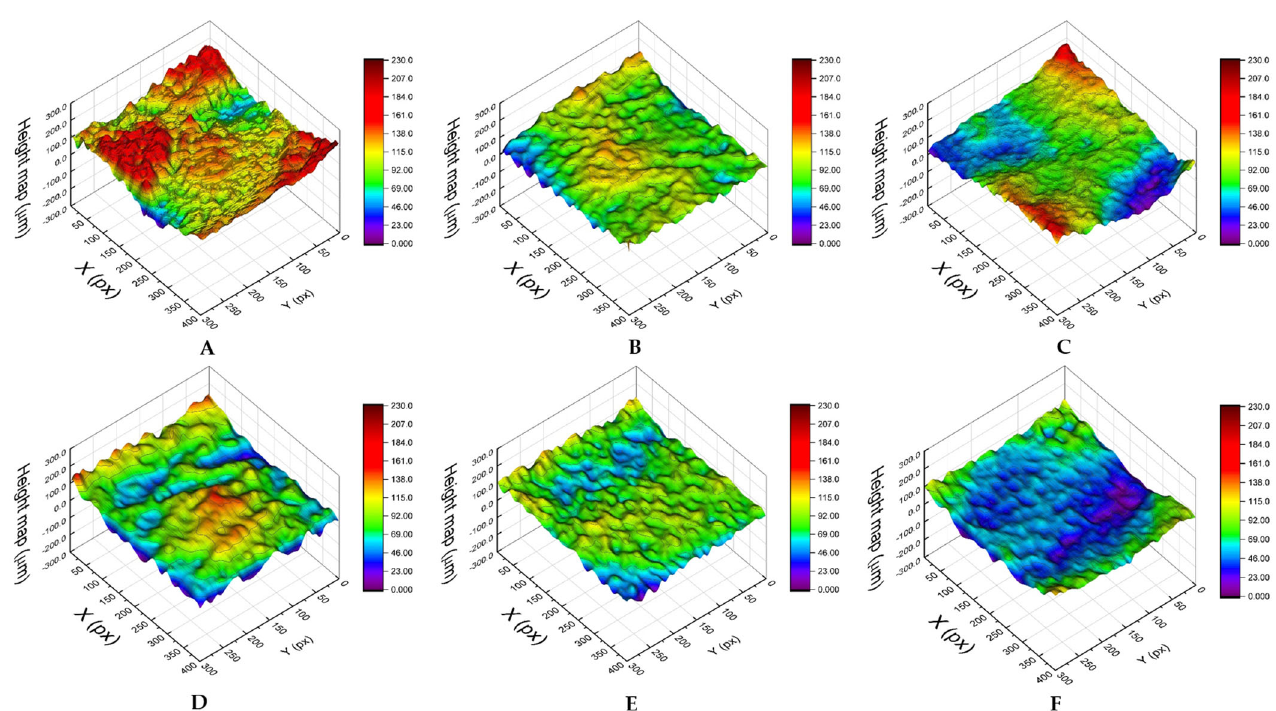
Different letters show significant differences for p ≤ 0.05, Tukey test. Data are means ± SD (n = 3–152).